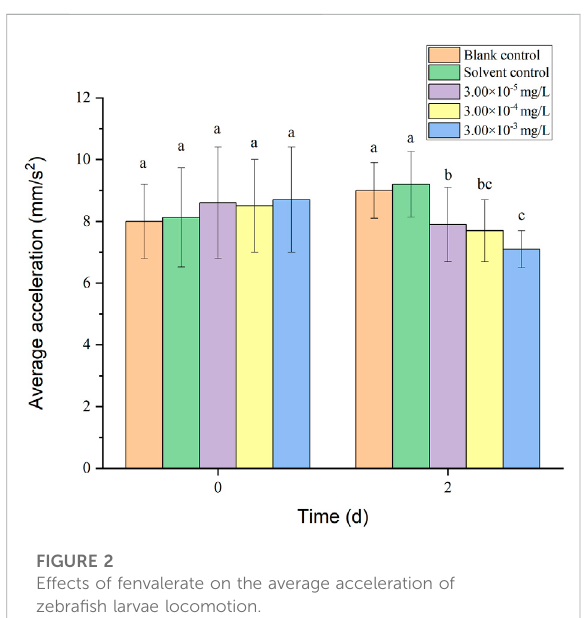
FIGURE 1 Effects of fenvalerate on the average velocity of zebra fi sh larvae locomotion.